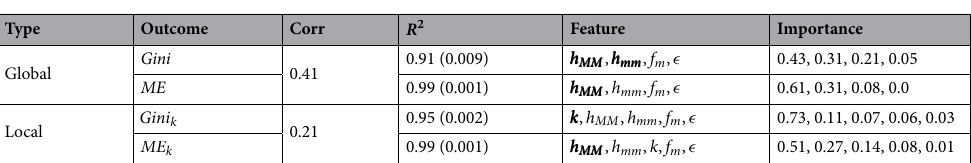
2 . Features are ranked in